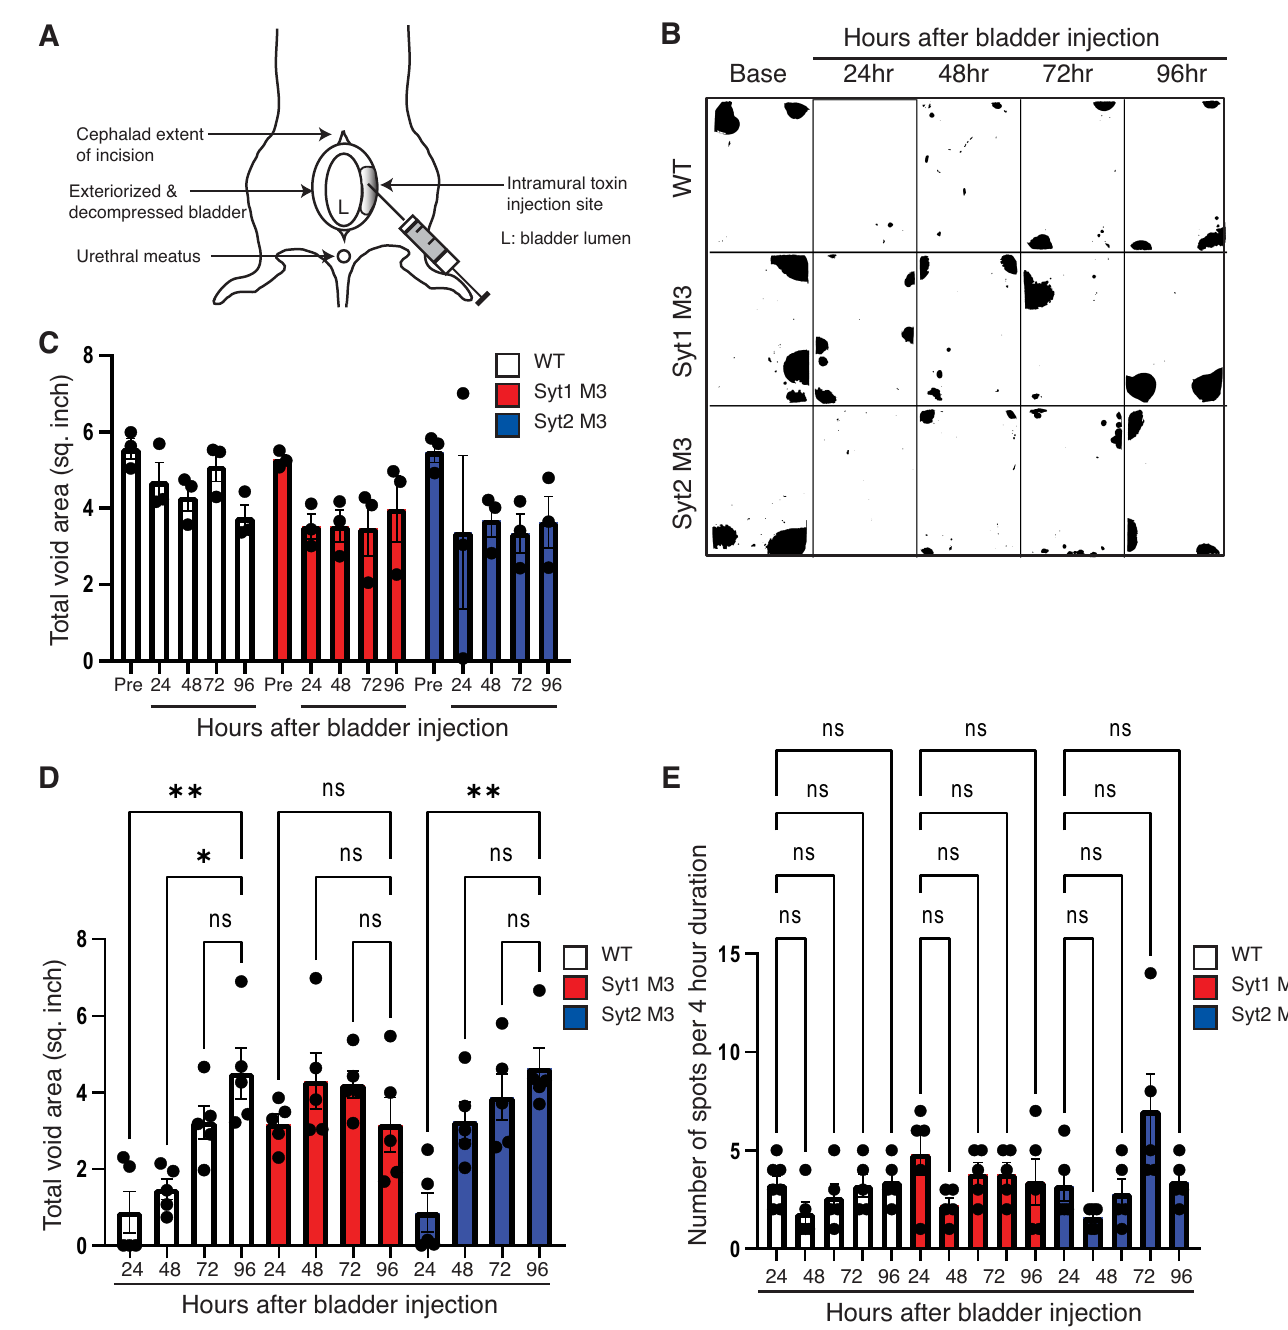
Fig 6. Analyzing BoNT-induced urinary retention in vivo. A. Schematic illustration of the bladder injection model. Mice were anesthetized with isoflurane and a low midline laparotomy was made. The bladder was exteriorized and decompressed of urine to thicken the bladder wall. BoNT/B was injected into the lateral walls of the bladder bilaterally. B. Mice injected with BoNT/B were subjected to 4-hour nighttime voiding spot assay every 24 hours for 4 days. Representative images for urine spots (black areas) are shown. C. Voiding spots quantified into total void areas (inch 2 ) demonstrate similar pre-injection urine volumes across WT, Syt1 M3 , and Syt2 M3 mice (n = 5 for each group). All groups showed a decline in voided volumes in sham controls that went through the surgery and injection procedures without toxins, likely from surgical manipulation of the bladder and the use of post-operative pain control narcotics. n = 3 for each group. D. At 24–48 hours post-injection, WT and Syt2 KI mice had significantly diminished voided volumes compared to Syt1 KI mice, with progressive recovery over 96 hours. � P < 0.05, �� P < 0.005, ns = not significant. E. Number of voiding spots per 4-hour nighttime evaluation showed no difference across genotypes, and across pre- and post-injection time points, demonstrating that voiding frequency is unchanged across groups. ns = not significant.